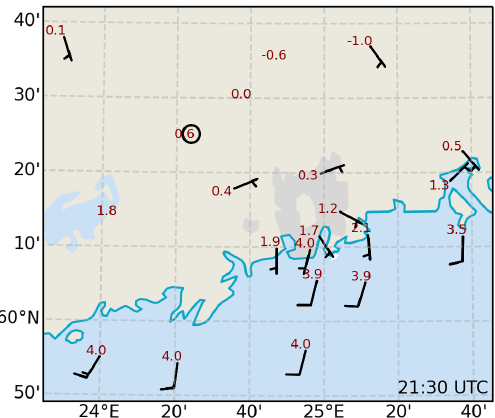
Figure 7. Surface observations of temperature and wind from of- ficial weather stations close to Helsinki on 27 January 2020 at 21:30UTC.